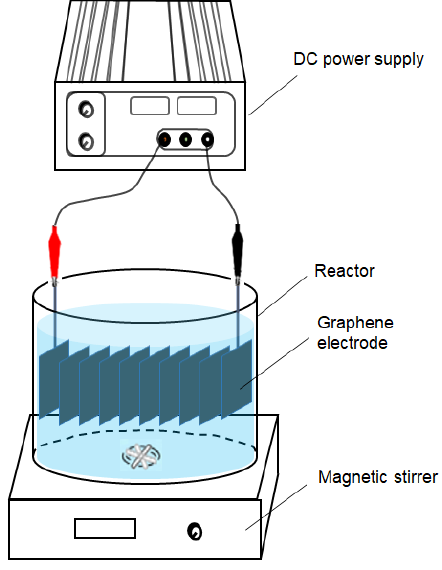
Figure 6. The experimental setup of the electrochemical process. Table 2. Electrochemical conditions during the spent caustic wastewater treatment.